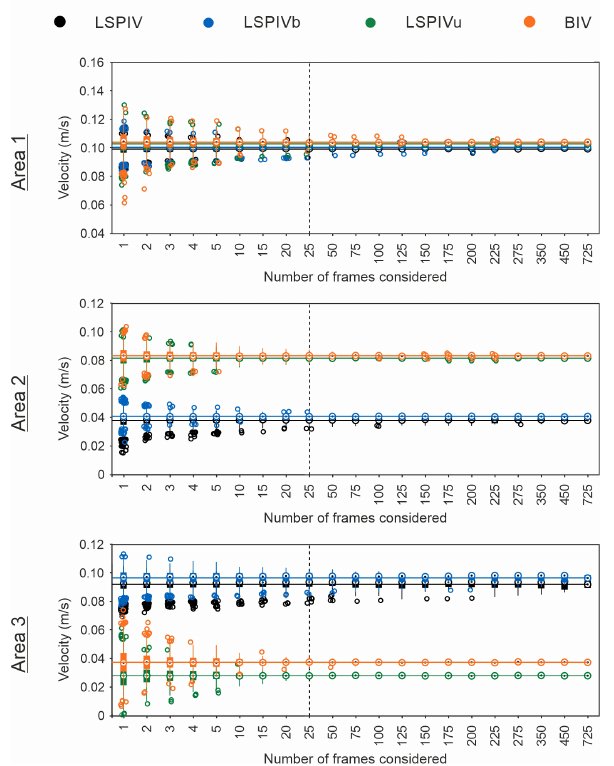
Figure 10. Mean velocity convergence study for rain intensity of 50mmh − 1 and Areas 1, 2, and 3. The horizontal line represents the mean velocity considering all the frames available (1500) for LSPIV (black), LSPIVb (blue), LSPIVu (green), and BIV (orange) techniques. Then, the variability in the mean velocity when the frames are divided into groups of different numbers of frames is represented by box